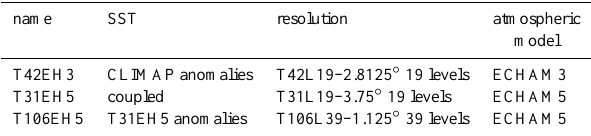
Table 1. SST × resolution atmospheric